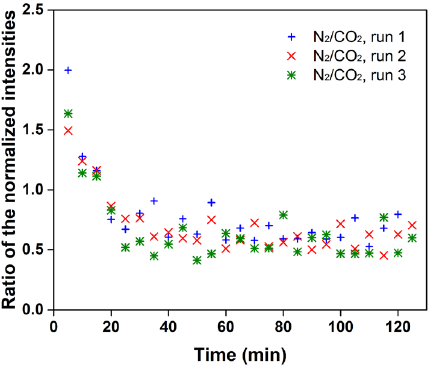
Figure 4. The ratio of the normalized intensities of N 2 and CO 2 molecules in hydrate formation from synthesized flue gas.